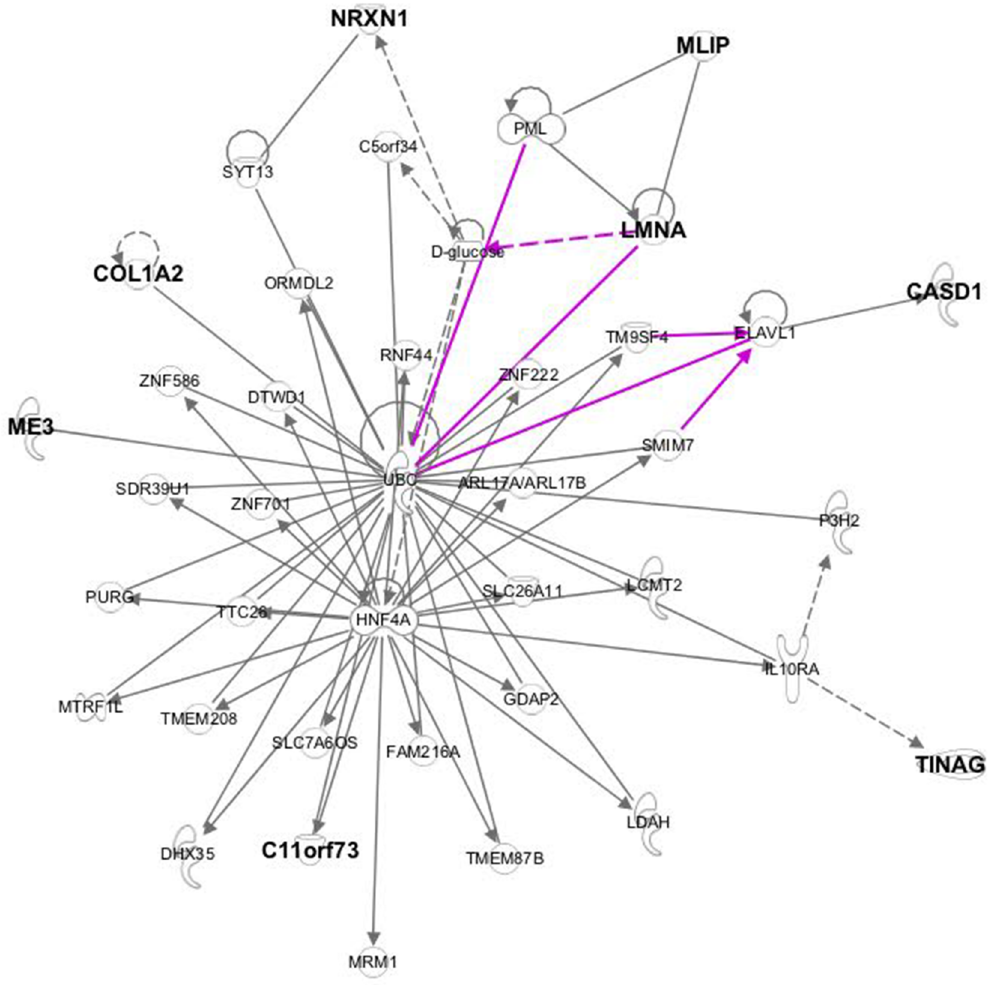
Fig 6. IPA merged network. The focus moleculesare indicatedin bold. One of the link moleculesin the merging networks is D-Glucose, important for the milk synthesis and involvedin the gluconeogenesis pathway.